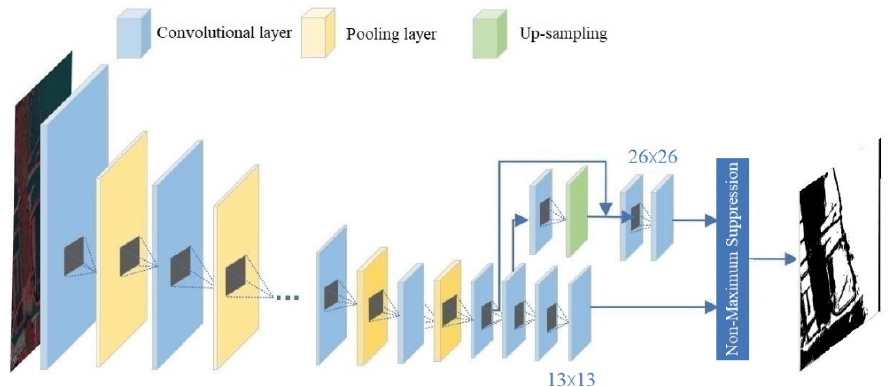
Figure 9. The network structure of the improved water detection